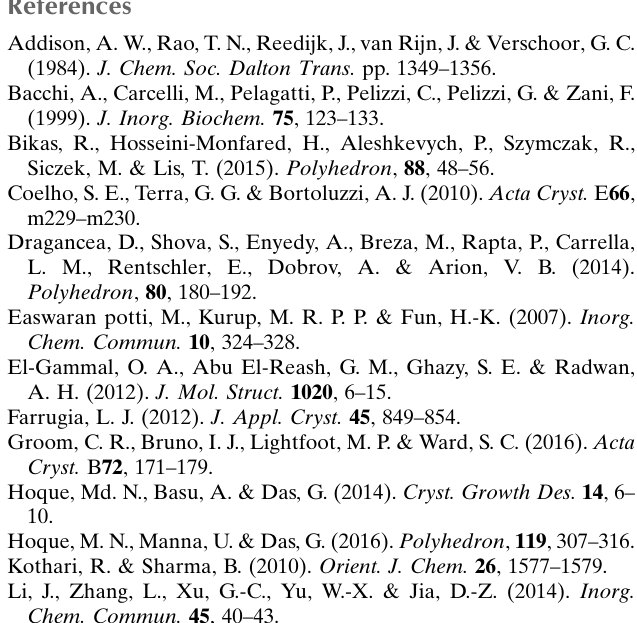
Table 3 Experimental details. Crystal data Chemical